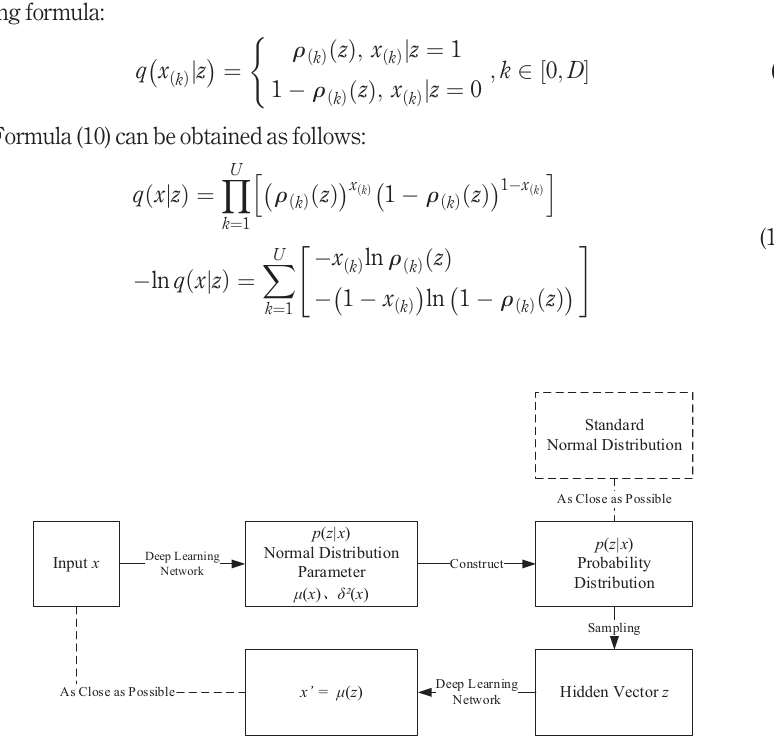
Figure 2. Use of deep learning to construct